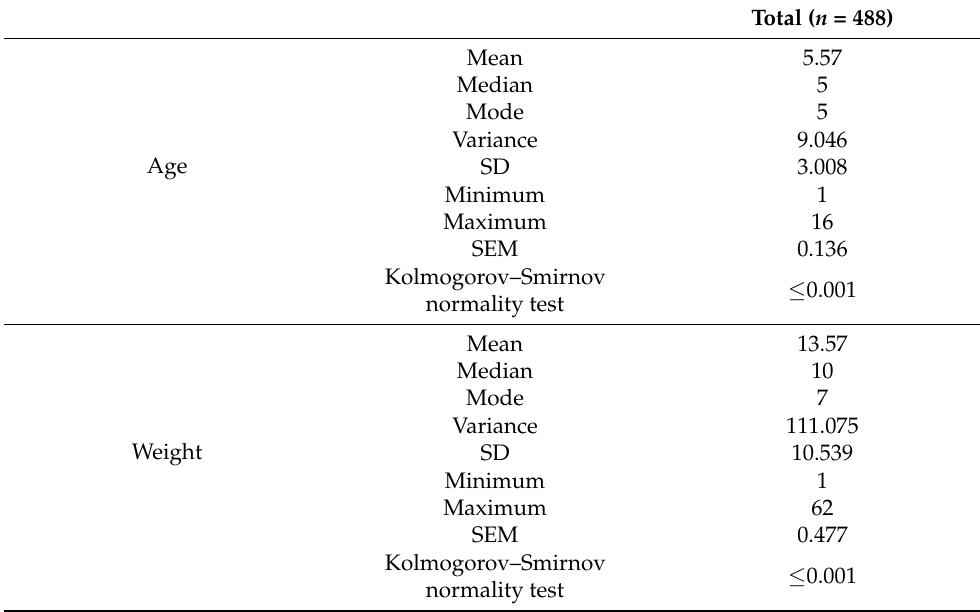
Table 3. Descriptive analysis of age and weight (n =